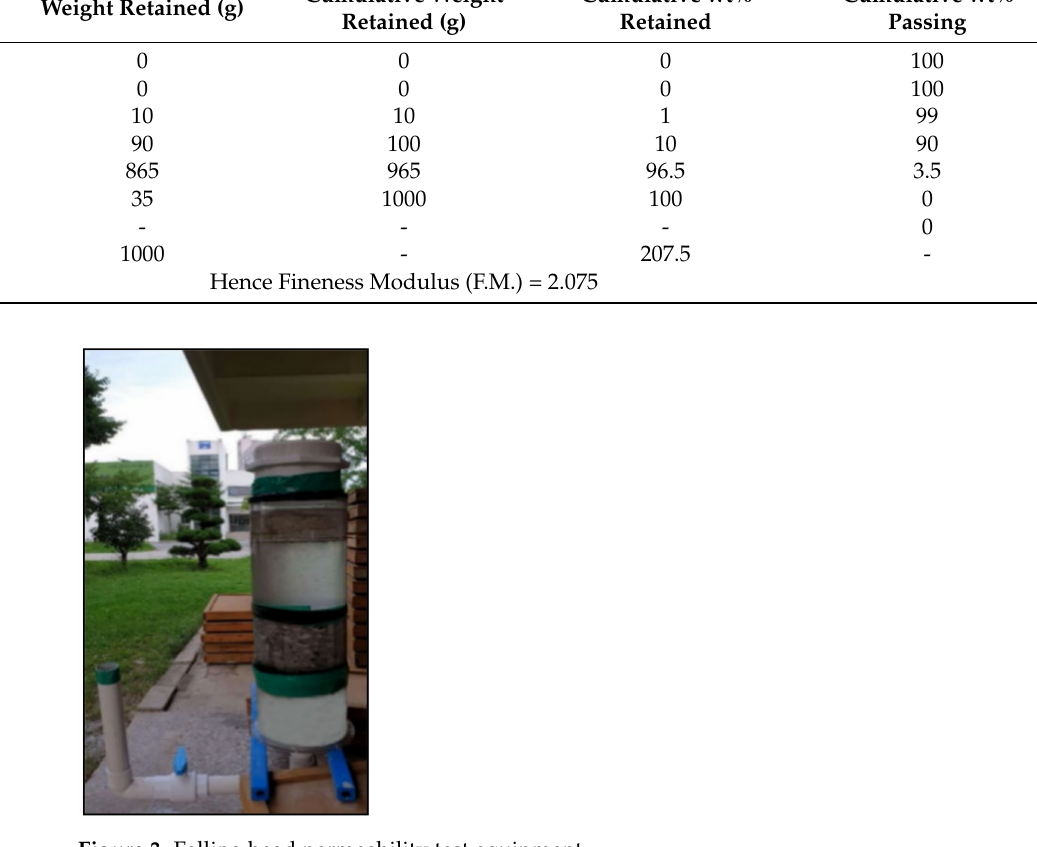
Figure 3. Falling head permeability test